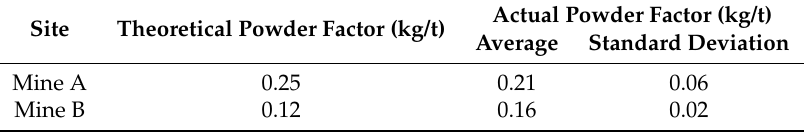
Table 5. Theoretical powder factor estimates, compared to the actual field values